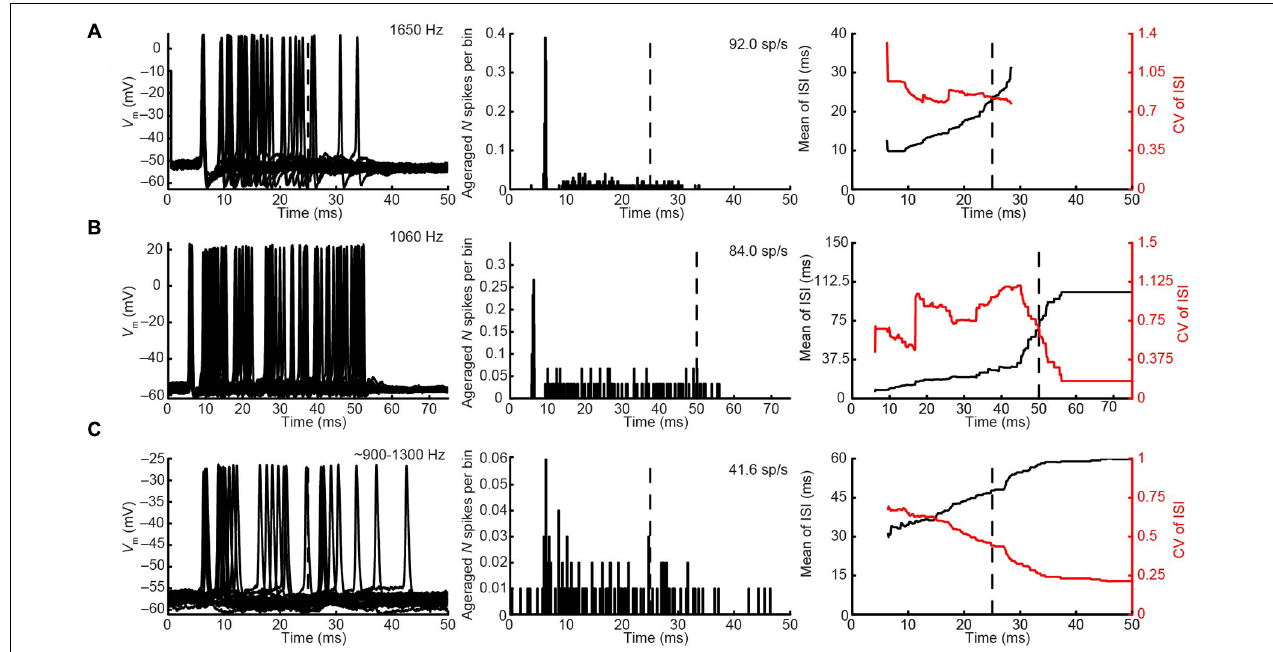
FIGURE 8 | Ipsilateral responses to short tones at CF for 3 pvLNTB neurons. (A–C) Each row corresponds to one pvLNTB neuron. Left panels: stacked intracellular responses to 20 repetitions of short monaural ipsilateral tones at CF. CF is indicated when known; for the neuron in C a frequency tuning function was not available but a CF-range is estimated from the response latency to short tones. For this neuron responses to 900 Hz tones are shown. Middle panels: PSTH. Bin size = 0.1 ms. Spike rate is indicated. Right panels: mean (black line) and CV (red line) of ISIs. The neuron in C corresponds to that in Figure 5 . Stimulus SPL and number of repetitions for the PSTH (middle column) were; (A) 80 dB SPL/100 repetitions, (B) 75 dB SPL/30 repetitions, (C) 90 dB SPL/100